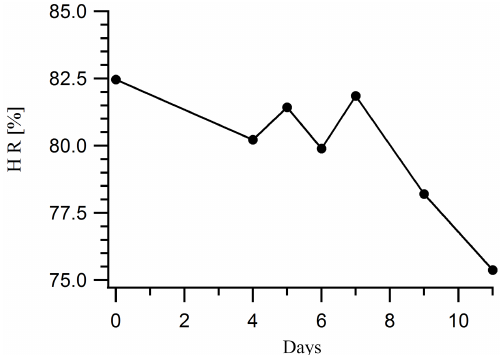
Figure 3. The influence of the ArF gas life time on the evolution of the laser hit rate (HR) over the